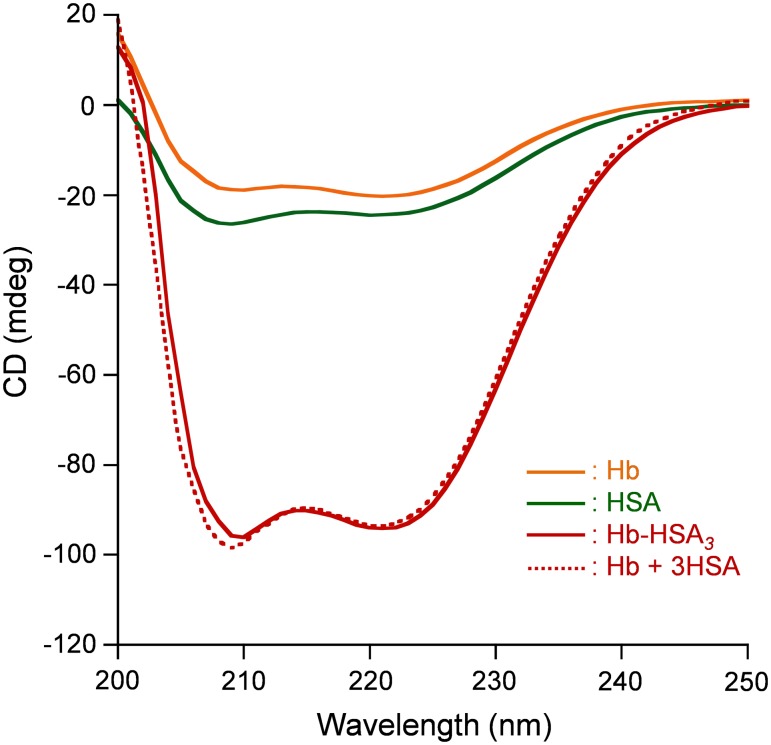
CD spectra of Hb, HSA, and Hb-HSA3.[Sample] = 0.2 µM in PBS solution (pH 7.4) at 25°C.